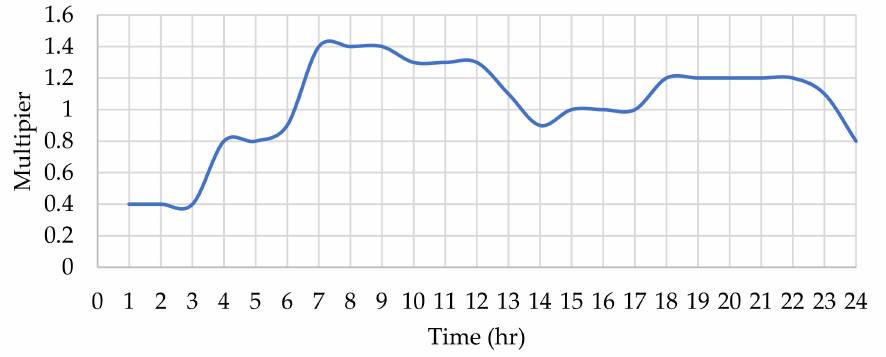
Figure A1. Water demand pattern [33].